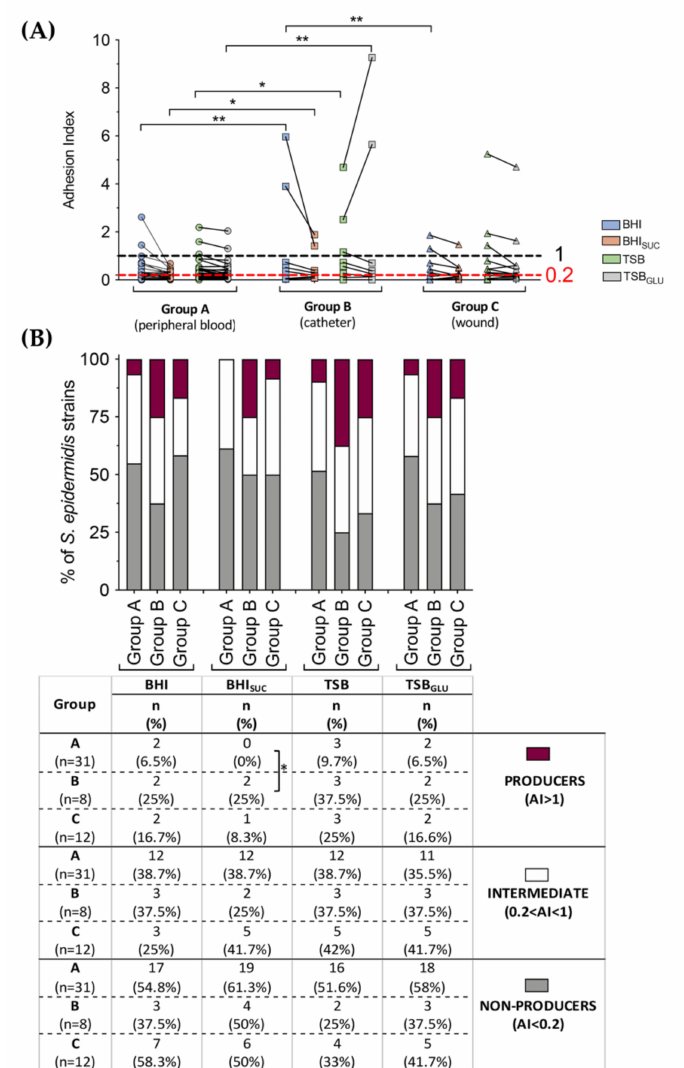
Figure 3. The biofilm formation of clinical S. epidermidis isolates. ( A ) Adhesion index, determined with the CV assay, of the clinical S. epidermidis strains isolated from the peripheral blood (Group A), catheters (Group B), or wounds (Group C) in different growth media as indicated. Data are repre- sented with dot-plots showing the median value of at least three independent experiments of each isolate grown in BHI ± SUC and TSB ± GLU. Statistical significance analyzed with one-way ANOVA was reported (* p < 0.05, ** p < 0.01). ( B ) Percentage and number of strains classified according to the adhesion index (AI) value in strong biofilm-producers (AI > 1; purple), moderate biofilm-producers (0.2 < AI < 1; white), and non-producers (AI > 1; light gray) among the S. epidermidis clinical isolates derived from peripheral blood (Group A), catheters (Group B), or wounds (Group C). Statistical analysis performed with Fisher’s exact test for each condition was reported (* p <